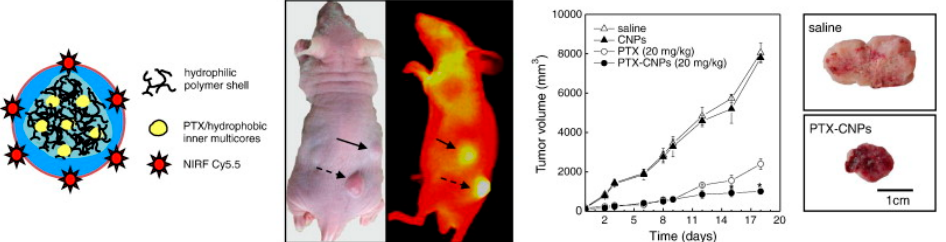
Figure 5. Schematic diagram of chitosan-based nanoparticles used in cancer diagnosis and therapy. Reproduced with permission from [109], 2010, Elsevier.